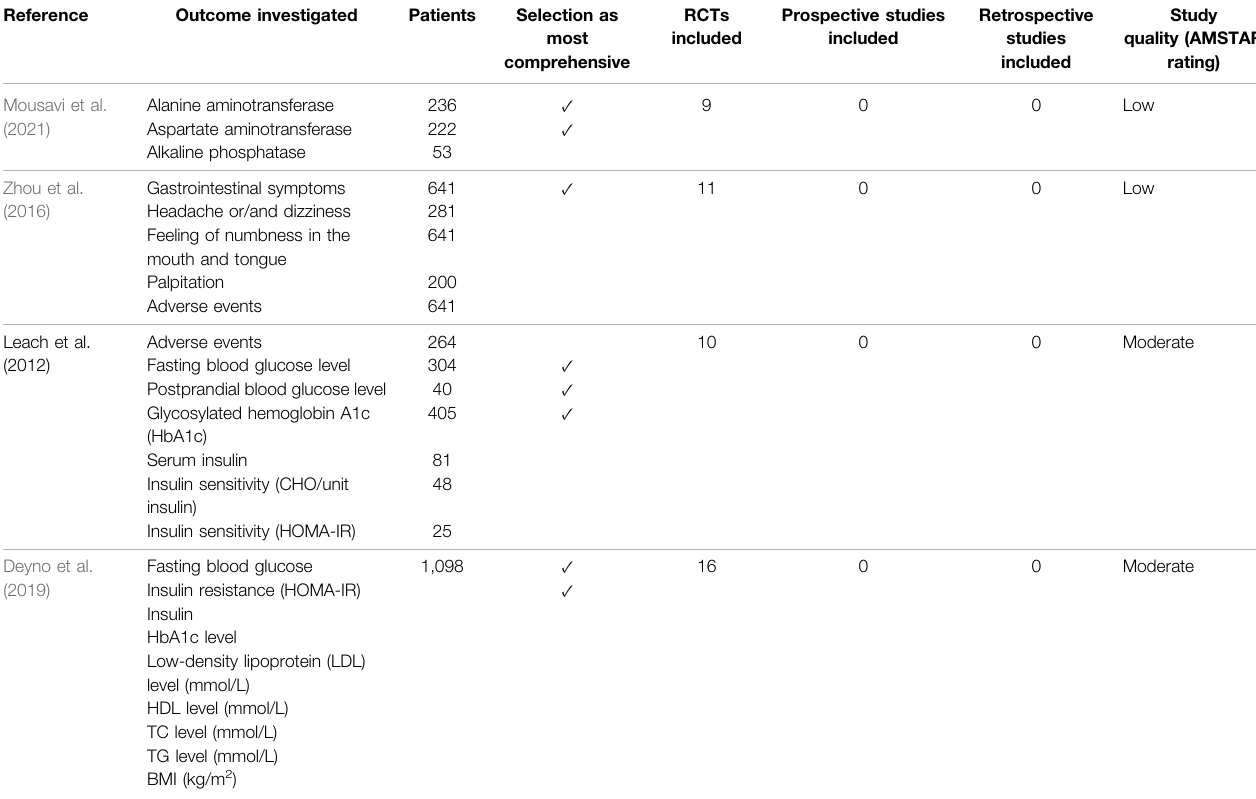
TABLE 2 | Characteristics of the included